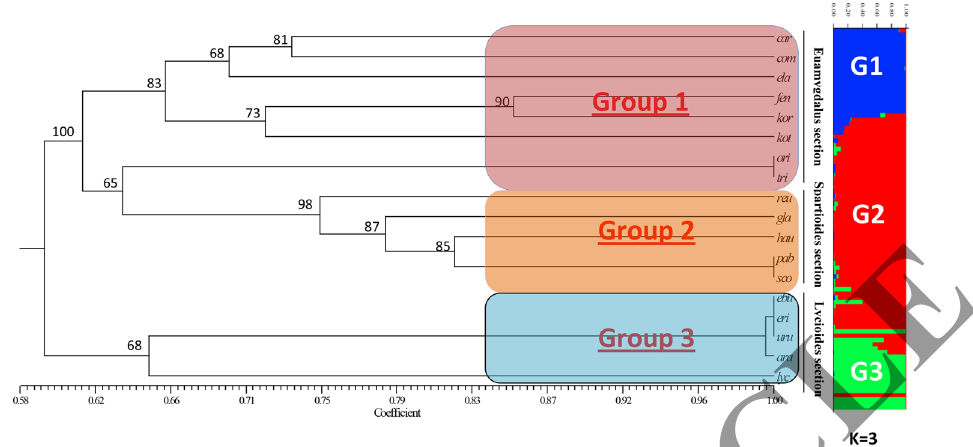
Figure 1. Dendrogram obtained with the similarity simple matching (SM) coefficient pair group method with the arithmetical average clustering algorithm from 289 IRAP markers for 389 wild almond species. The value on the dendrogram gives the stability of nodes estimated with a bootstrap procedure (no number indicates support less than 10%). Bar graphs showing genetic diversity structure for the 389accessions of Prunus species as assessed using STRUCTURE software. Each group is represented by a different color (blue, red and